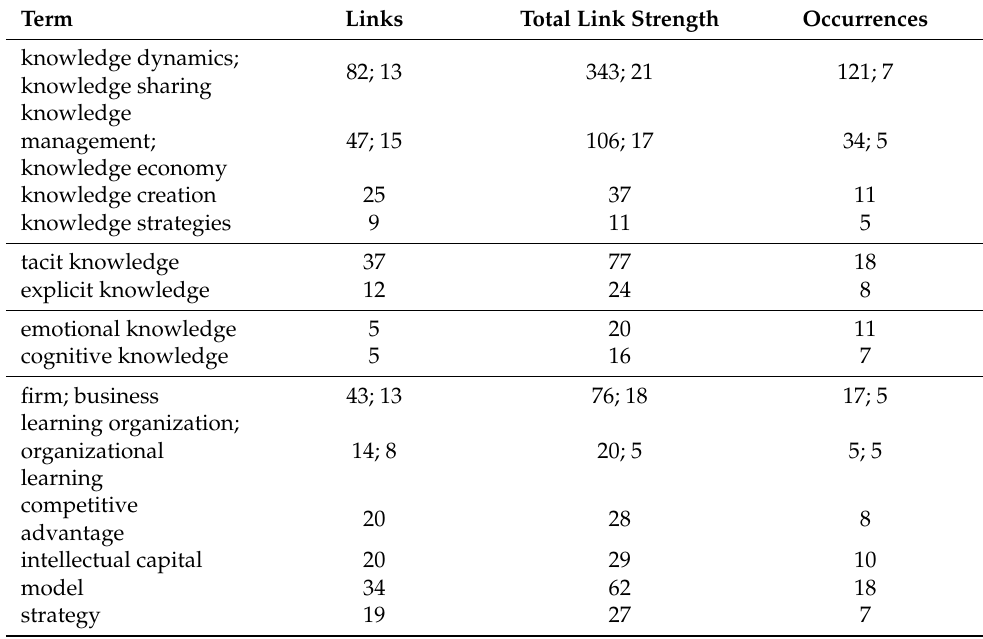
Table 5. KD: Cluster 2 (Knowledge Dynamics): most relevant 14 expressions by VOSviewer (Source: authors’ own